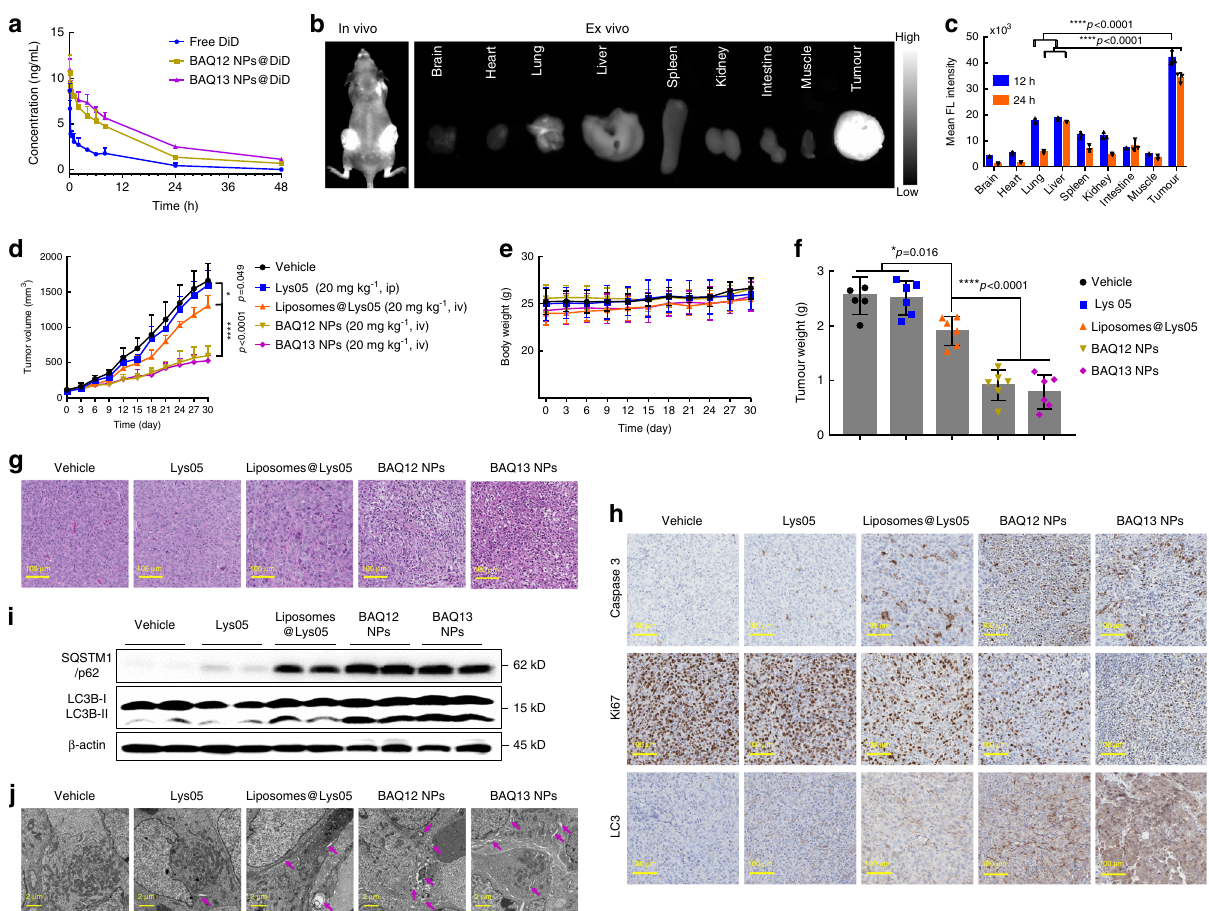
Fig. 5 The pharmacokinetics, biodistribution and in vivo antitumour effect of BAQ ONNs. a The plasma concentration-time pro fi les of DiD-loaded BAQ ONNs and free DiD after intravenous injection; data are mean values± SD; n = 3. b In vivo and ex vivo biodistribution of BAQ13 NPs in mice bearing HT29 tumours at 24 h post injection. c Quantitative fl uorescence intensity of tissues obtained at 12 and 24 h post injection; data are mean values± SD; n = 3. d MIA PaCa-2 tumour growth curves in mice that were treated as indicated every 3 days; data are mean values ± SD; n = 6 tumours per group. e Body weight of mice during the treatment; data are mean values ± SD; n = 6 mice per group. f Weight of harvested tumours at the end of the treatment; data are mean values± SD; n = 6 tumours per group. g – j Representative H&E ( g ), IHC ( h ), immunoblotting ( i ) and TEM ( j ) results of tumours that were harvested at the end of treatments; Blots in i were from three individual tumours of each group; purple arrows in j : autophagic vesicles; experiments in g – j were all repeated three times independently. All statistical p values were calculated by one-way ANOVA with the Tukey ’ s multiple comparison test; * p < 0.05; **** p <